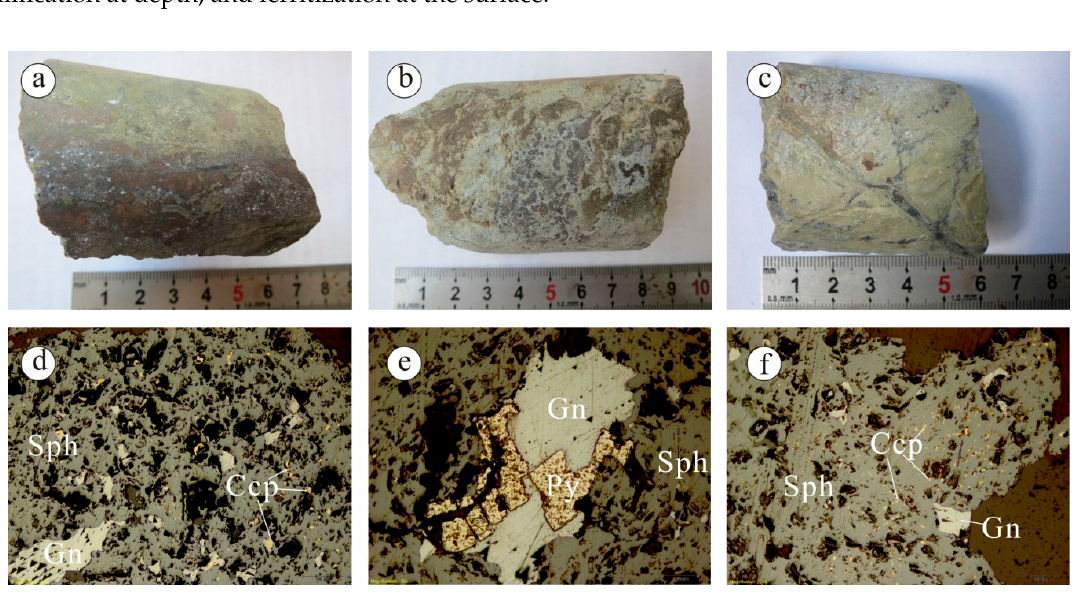
Figure 6. Photographs and photomicrographs showing ore geology of the Pb-Zn deposit in Diyanqinamu mine. ( a ): massive Pb-Zn ores; ( b ): disseminated Pb-Zn ores; ( c ): veined Pb-Zn ore; ( d ): sphalerite displaying chalcopyrite disease structure coexists with galena; ( e ): sphalerite showing chalcopyrite disease structure coexists with pyrite and galena; ( f ): sphalerite showing chalcopyrite disease structure coexists with galena. Gn: Gelana; Sph: Sphalerite; Py: Pyrite; Ccp: Chalcopyrite.